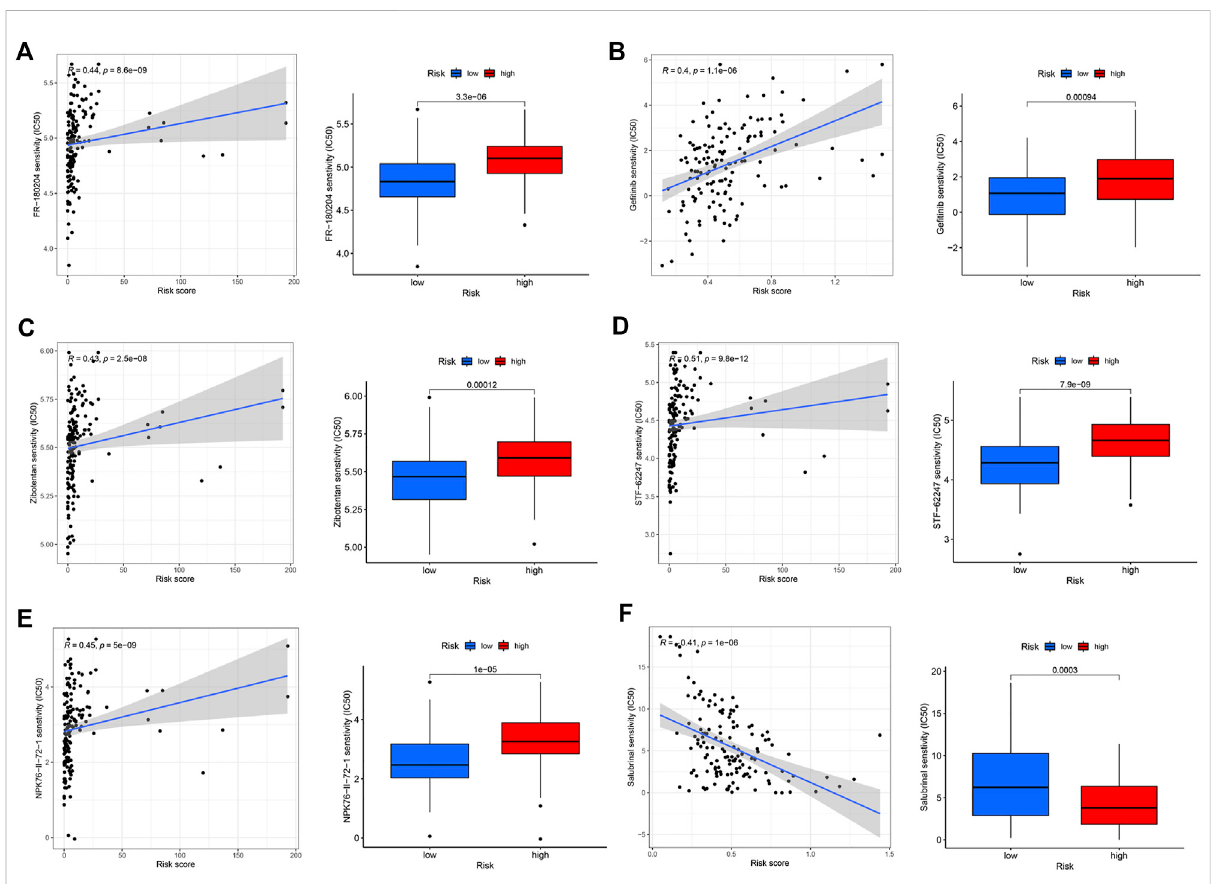
FIGURE 5 Drug sensitivity analysis of the high- and low-risk groups. (A) FR-180204. (B) Ge fi tinib. (C) Zibotentan. (D) STF-62247. (E) Npk76-ii-72-1. (F)